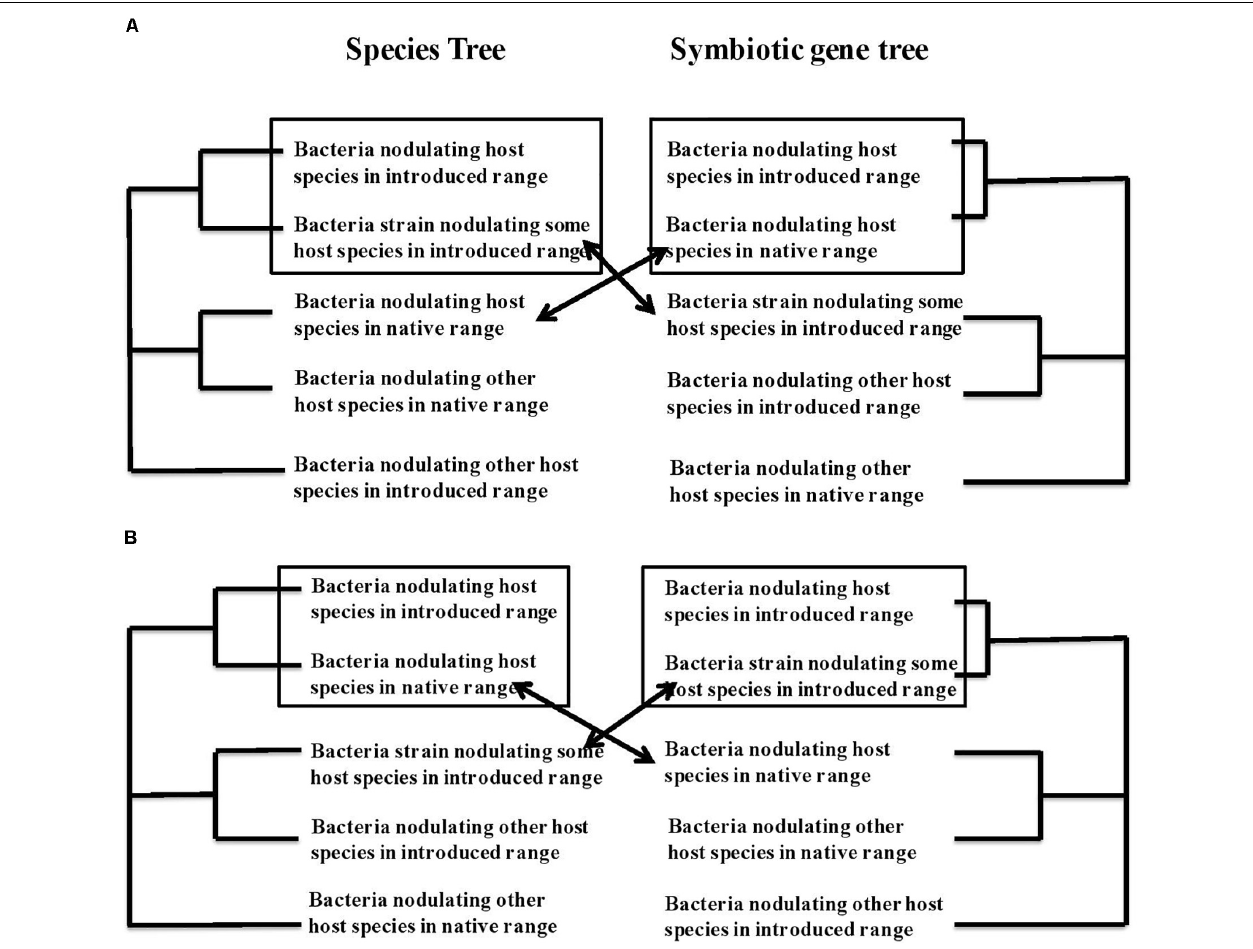
FIGURE 2 | Phylogenetic trace of co-introduction or acquisition of a new symbiotic partner together with recombination between bacterial strains to generate chimeric symbiotic partners with core genetic markers and symbiotic genes that show different phylogenetic patterns. (A) Depicts what we subsequently call scenario 3, with a new symbiotic partner acquired in the new geographic range that resembles some local bacteria for core genes but that has recombined with the original symbiont to acquire the symbiotic genes specific to the original interaction, and thus resembles the original symbiotic partner at its symbiotic genes. (B) Depicts the opposite scenario, hereafter referred to as scenario 4 with co-introduced symbionts that resemble the bacteria from the native range of the host plant for core genes but has recombined to acquire new symbiotic genes from bacterial species present in the introduced range. As in Figure 1 we assume some geographic pattern to relationships of the bacteria, with species from the same geographic range showing more